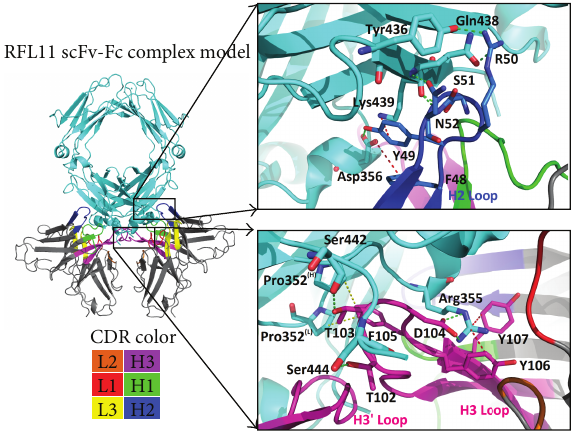
Figure 8: The interface structure of the RFL11-Fc was focused on the CDR-H2 (colored in blue) and CDR-H3 (colored in magenta) loops in this panel. Human IgG Fc antigen was colored in cyan. The colorsofthesixCDRsofRFL11werethesameasthatinFigure 6.The format of residues of Fc antigen and H2/H3 loops is abbreviated as three words and residues codes for distinguishing between antigen and antibody, respectively. The green and red dotted lines in the above panel represent H-bonding and anion-cation interactions of RFL11 with Fc, respectively. In the below panel, the green, red, and yellow dotted lines show H-bonding, cation-pi, and hydrophobic interactions,